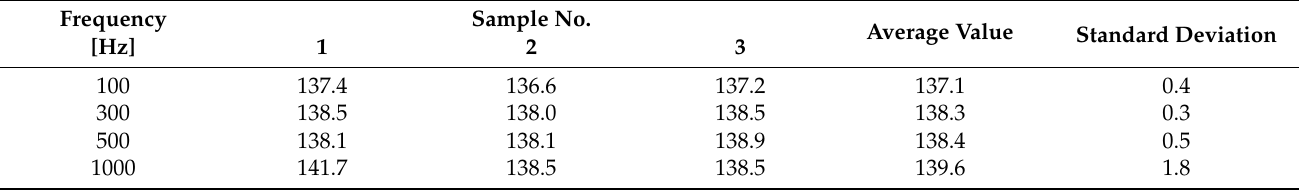
Table 3. Dynamic stiffness (dB re. 1 N/m) for PSMA5 poroelastic pavement with SMA11 as binder course — measurements in situ (S). Sample No.